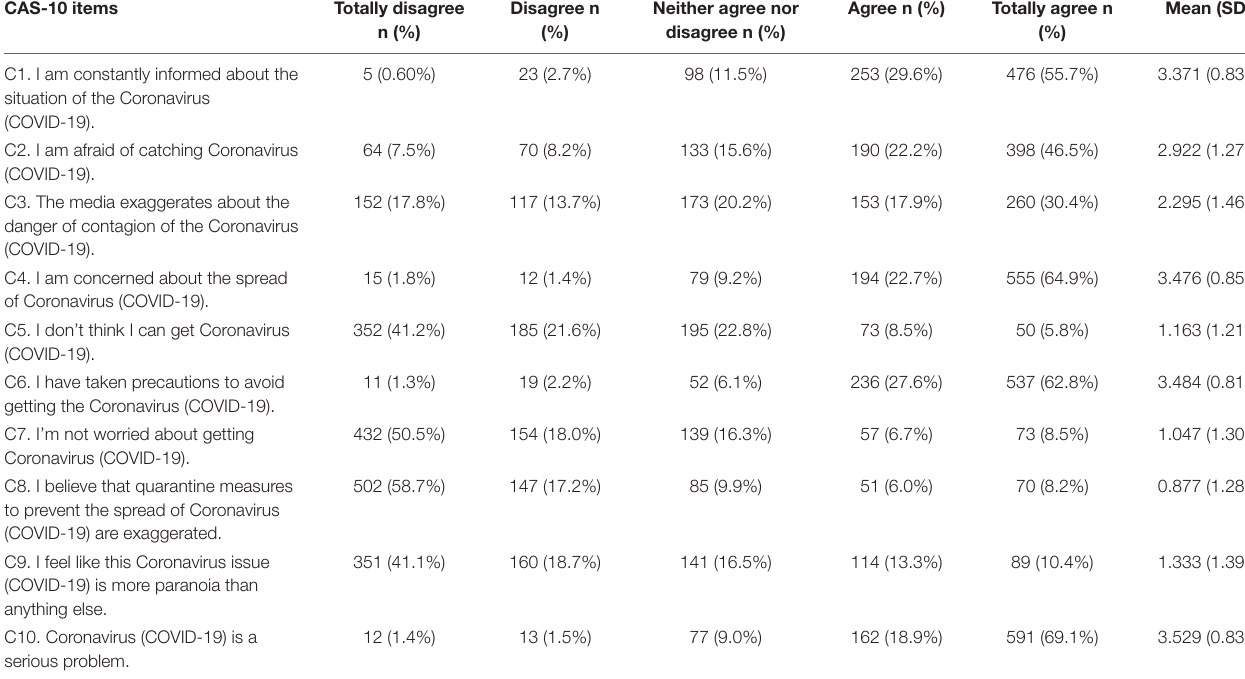
TABLE 2 | Descriptive statistics for each CAS-10